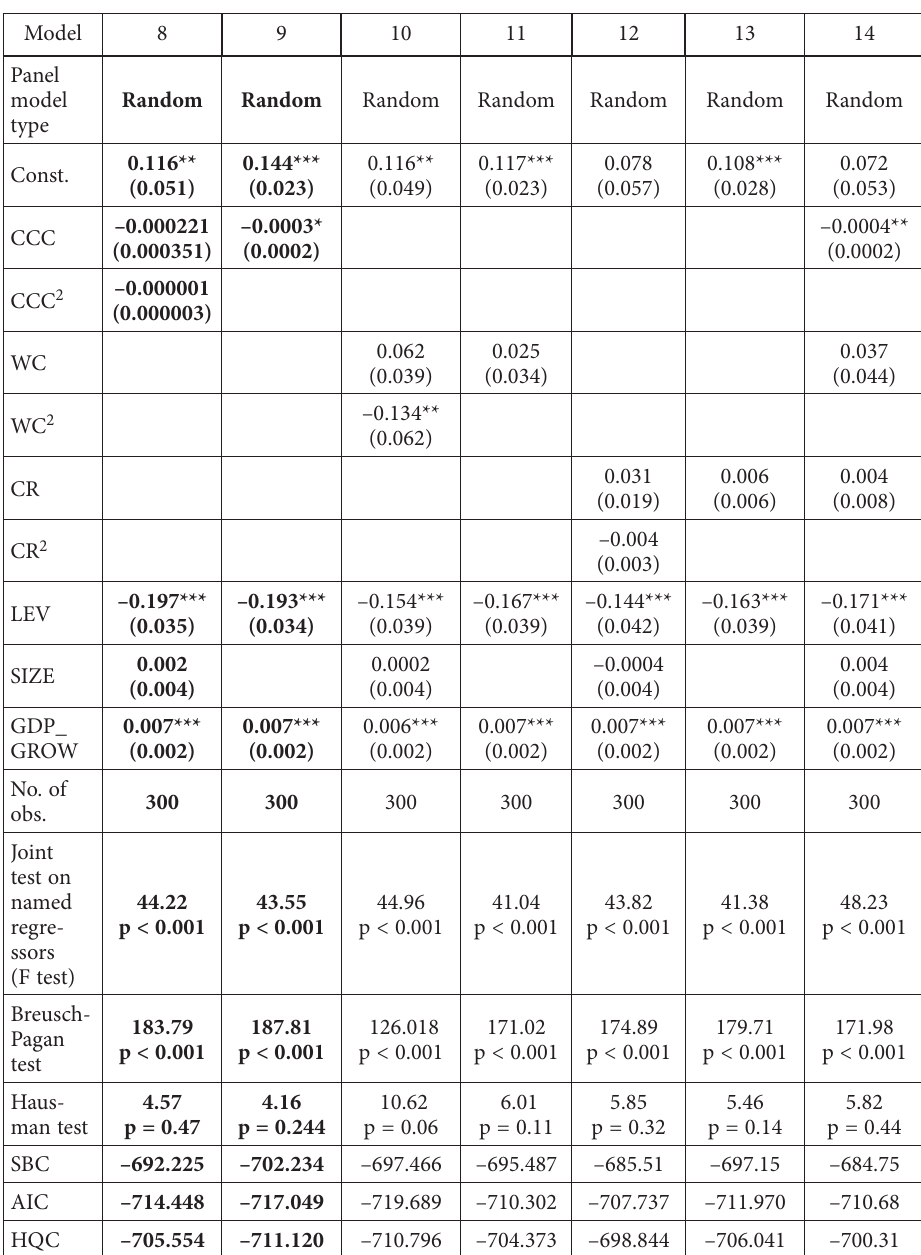
Table 8. Results of model estimation (“Chemicals” industry) (source: own elaboration)